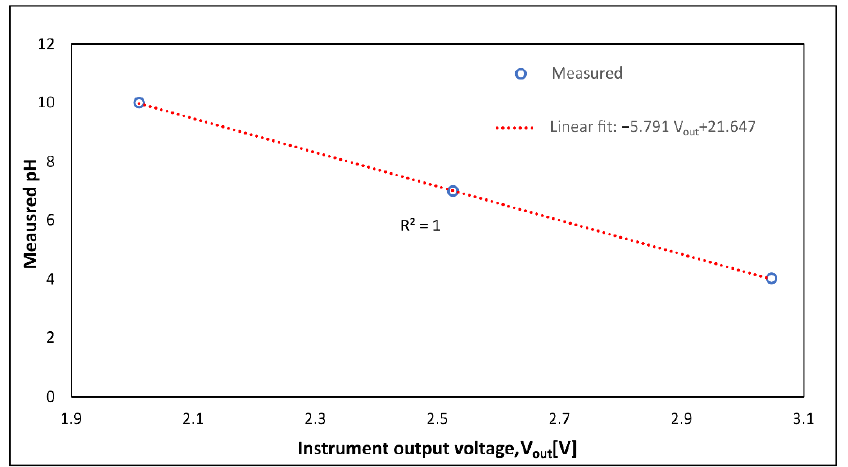
Figure 6. The calibration curve enables the direct measurement of pH from the instrument output.